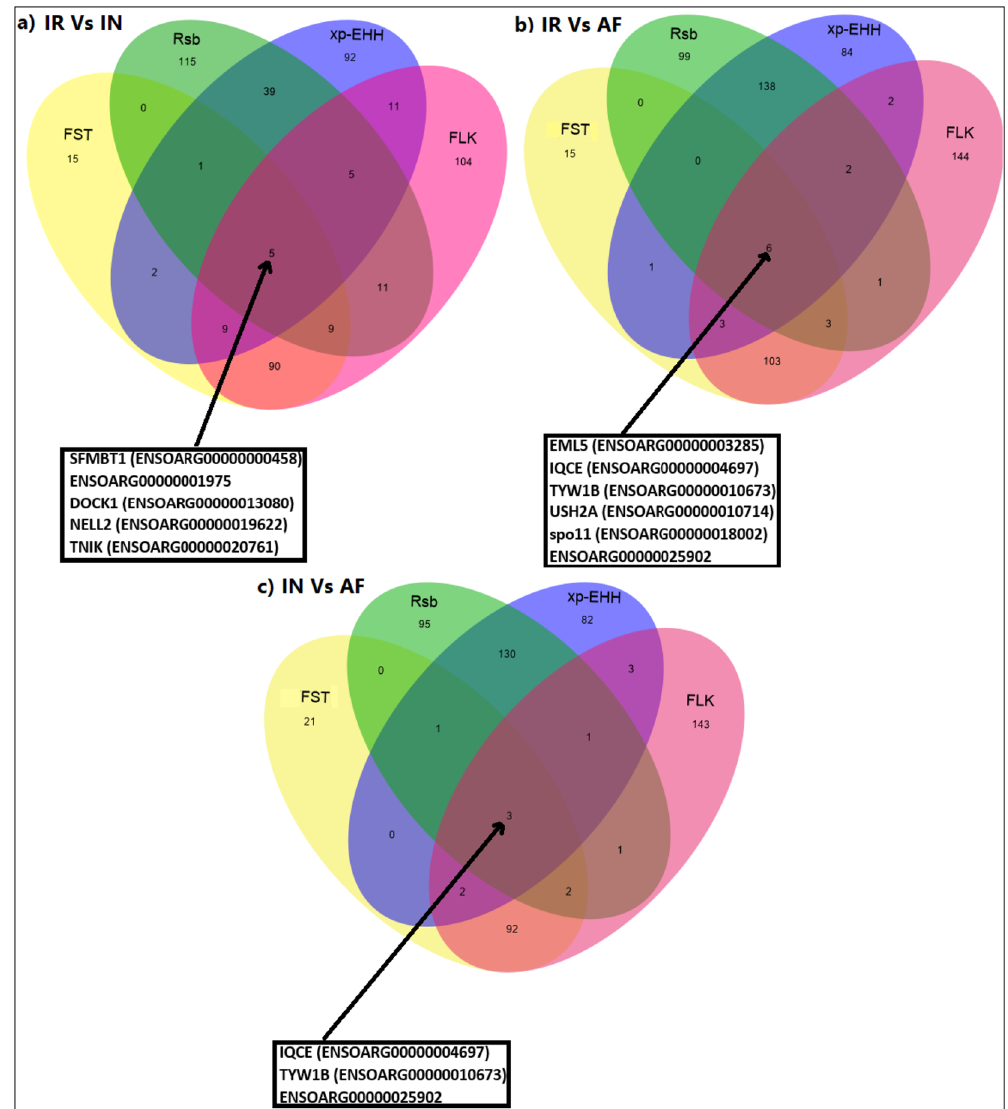
Figure 8. Venn diagram showing the unique and shared candidate genes for FST, Rsb, xp-EHH, and FLK tests on: ( a ) IR vs. IN, ( b ) IR vs. AF, and ( c ) IN vs. AF sheep breeds. For breed abbreviations, see Table